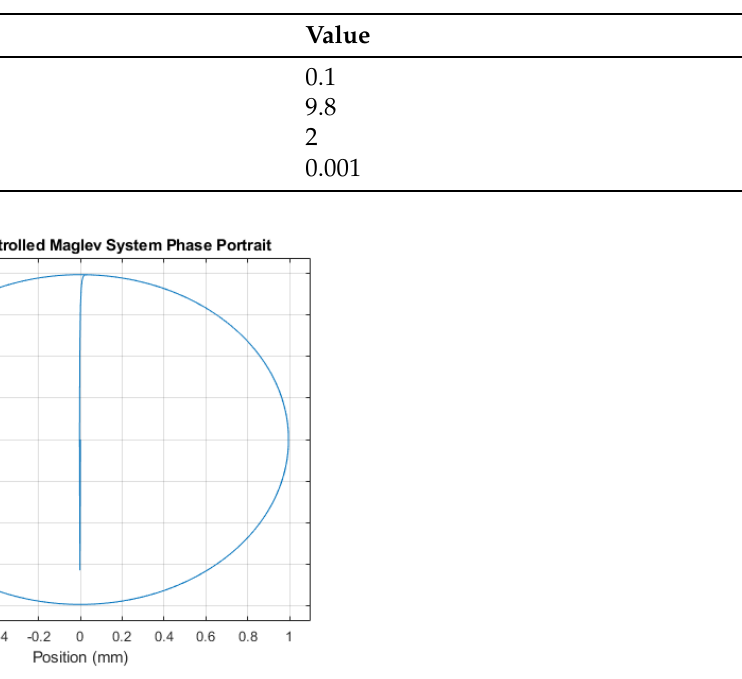
Figure 4. Phase portrait of the Maglev system with a reference sinusoidal wave of 40 rad/s frequency under Lyapunov